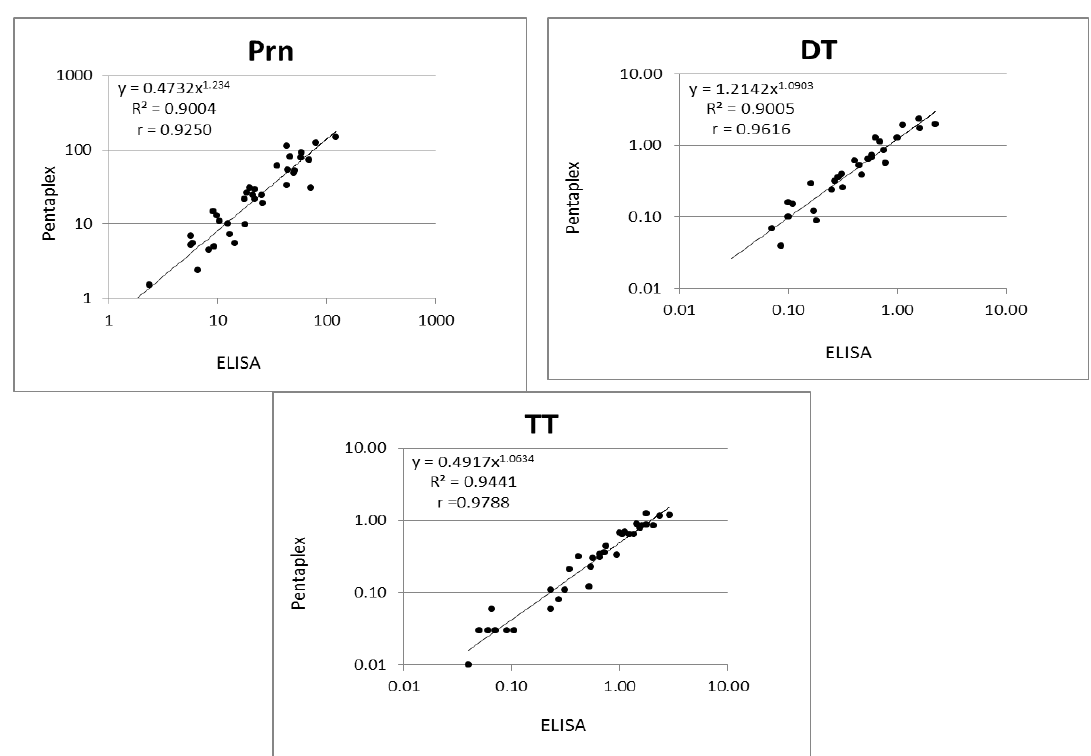
Figure 3. Correlation of IgG concentrations to DTP antigens obtained with pentaplex immunoassay (MIA) and commercial ELISAs. Serum samples ( n = 37) were measured by both methods as described in the Materials and Methods section. Antibody concentrations in International Units per milliliter (IU/mL) shown after log transformation are shown for DTP antigens. R 2 represents the linear regression coefficient obtained using Microsoft Excel, and r represents the non-parametric Spearman correlation coefficient as calculated with GraphPad Prism Version 6 ( p < 0.0001 for all five analytes).